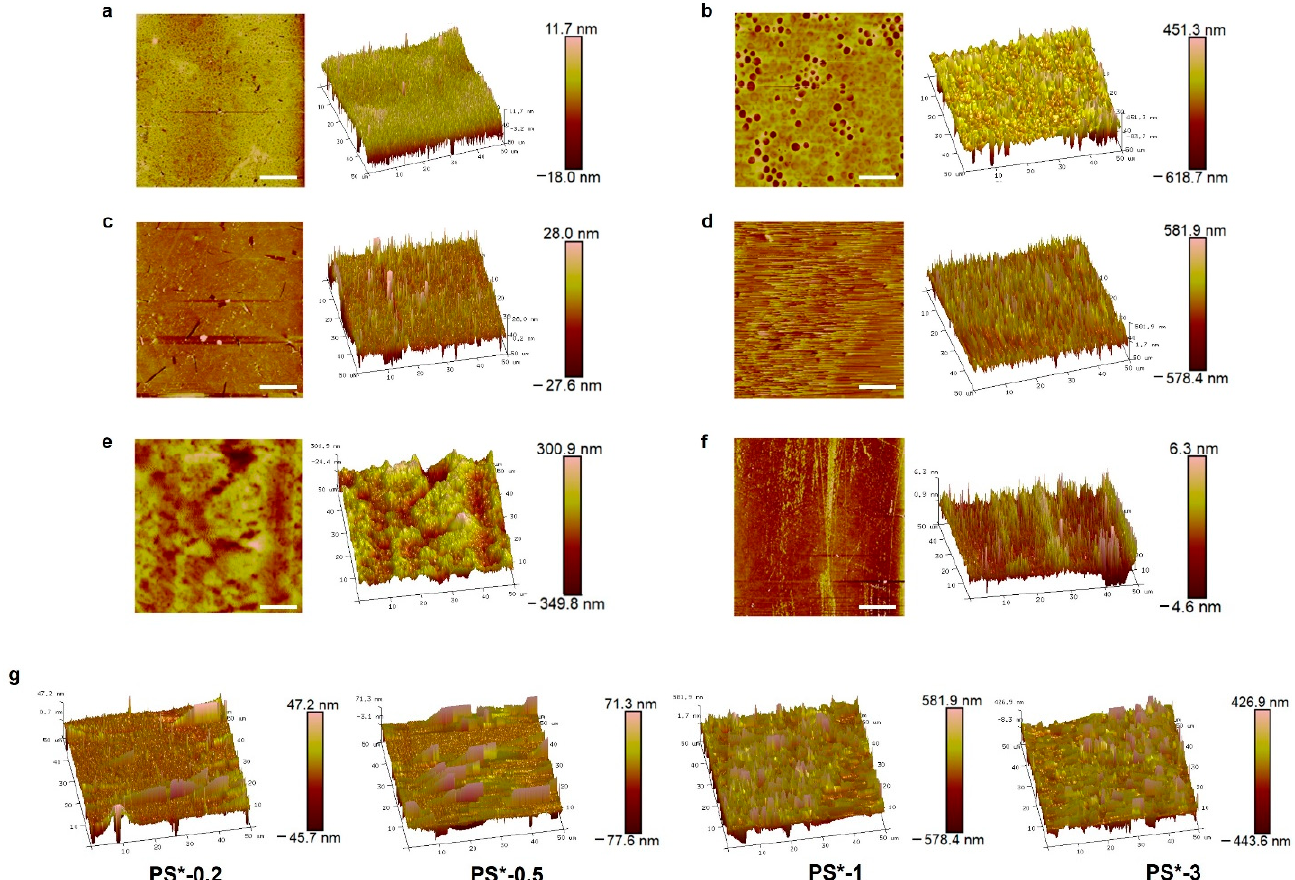
Figure 2. AFM topography images of PS films: ( a ) PS-control (C, chloroform); ( b ) PS*-1 (C); ( c ) PS-control (T, toluene); ( d ) PS*-1 (T); ( e ) PS#-1 (T); ( f ) PS-BZK C12 (T); ( g ) AFM images of PS* samples with different PIM-Vinyl loading amounts (PS*-0.2 (0.2 wt.%), PS*-0.5 (0.5 wt.%), PS*-1 (1 wt.%) and PS*-3 (3 wt.%)). Surface nanostructure was clearly increased from PS*-0.2 to PS*-3. Rough surfaces with different structure arrangement can be observed on PS*-1/PS#-1 samples. Scale bars, 10 µm on AFM images.